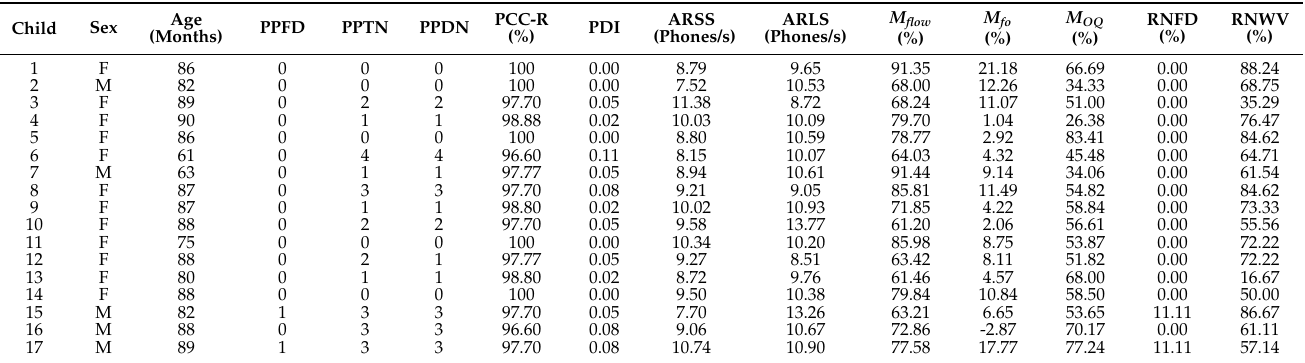
Table 2. Outcomes of an initial speech and language assessment and mean values of aerodynamic and EGG-based measures of the control group.